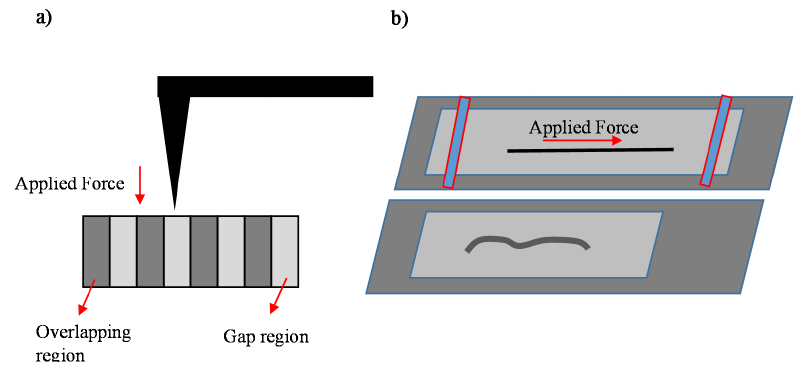
Figure 4. ( a ) Determination of the radial modulus using the AFM indentation method, ( b ) Determi- nation of the tensile modulus using AFM